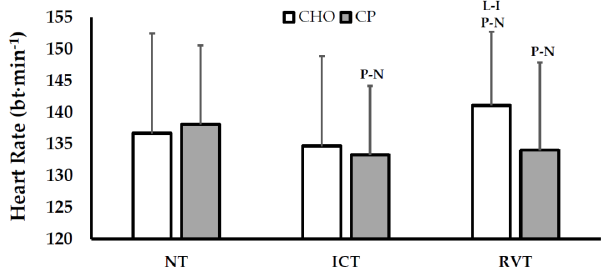
Figure 3. Heart Rate Responses (Mean ± SD) during Constant ‐ Load Cycling (50% Wmax). Within ‐